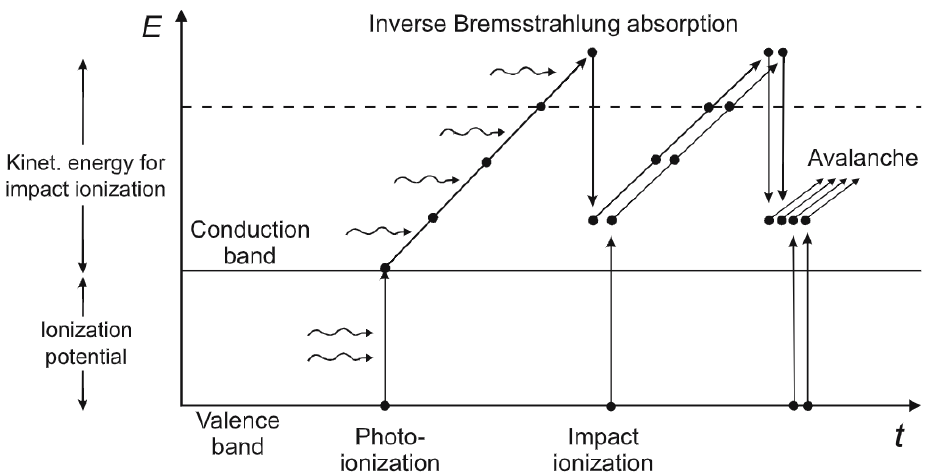
Figure 2. Schematics of the general mechanisms at the origin of the energy deposition in polymeric materials. Excitation into the conduction band (ionization) leads to quasi-free electrons still loosely bound to atoms. The excitation energy into the conduction band can be provided either by MPI or TI, depending on the Keldysh parameter, or by impact ionization from an energetic quasi-free electron that has gained its energy through photon absorption in a non-resonant process called ‘inverse Bremsstrahlung’ in the course of collisions with ions. This process is also at the origin of the avalanche ionization. Reprinted with permission from